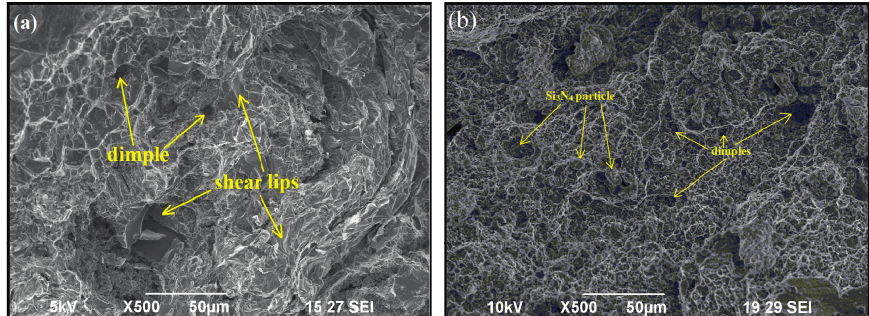
Figure 10: SEM micrographs of the fracture surface of the tensile specimen of (a) AA6061 alloy and (b) AA6061/20 wt.% Si